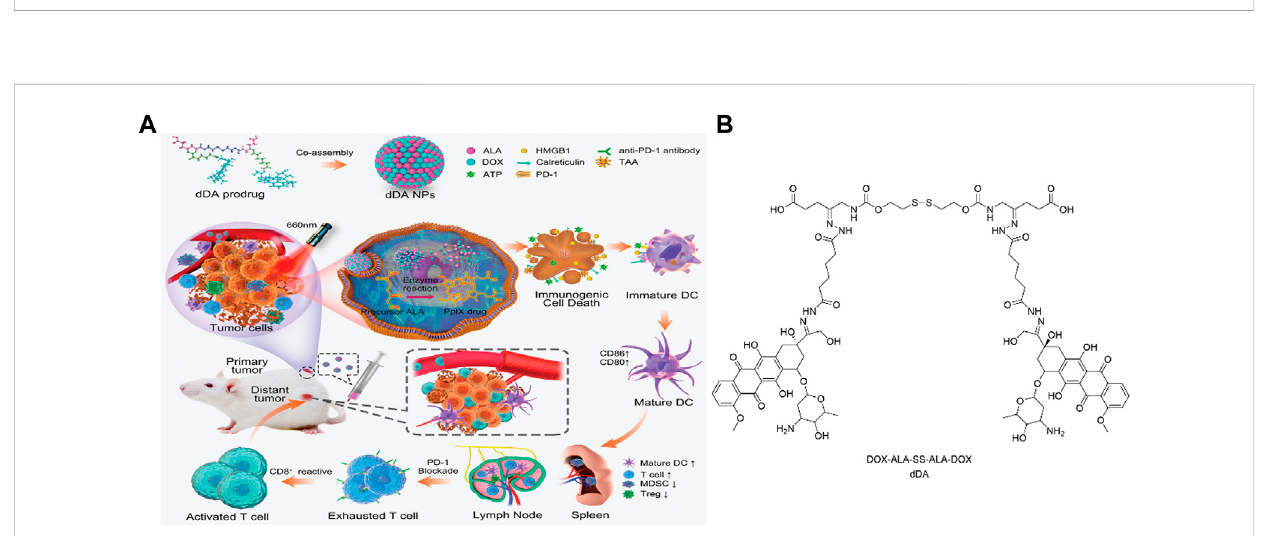
FIGURE 13 (A) . Design and mechanism of pH/GSH dual responsive dDA nanoparticles; (B) . Molecular structure of dDA. Adapted from ref. (Bai et al., 2020). Copyright 2020 WILEY-VCH Verlag GmbH & Co. KGaA,